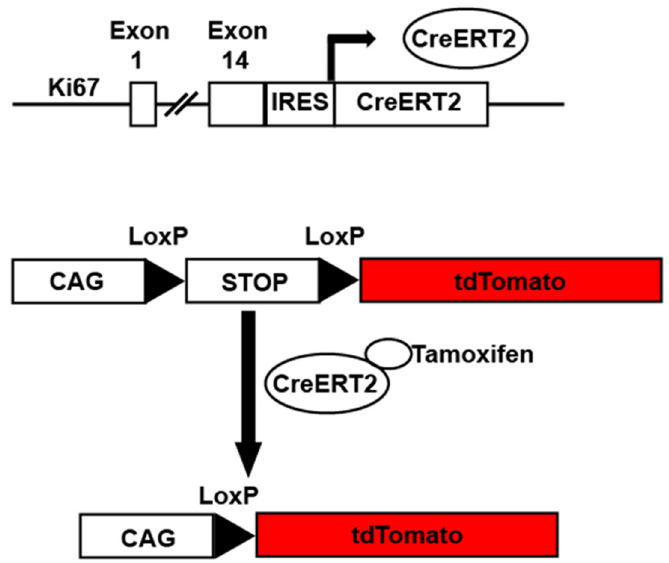
Figure 4. Ki67 iresCreER mice. Example of Ki67 iresCreER ::CAG-Lox-STOP-Lox-tdTomato mice. In the presence of tamoxifen, cells undergoing cycling as defined by Ki67 expression have activated Cre recombinase. The activated Cre excises a STOP cassette allowing tdTomato expression under the control of the constitutively active CAG promoter.